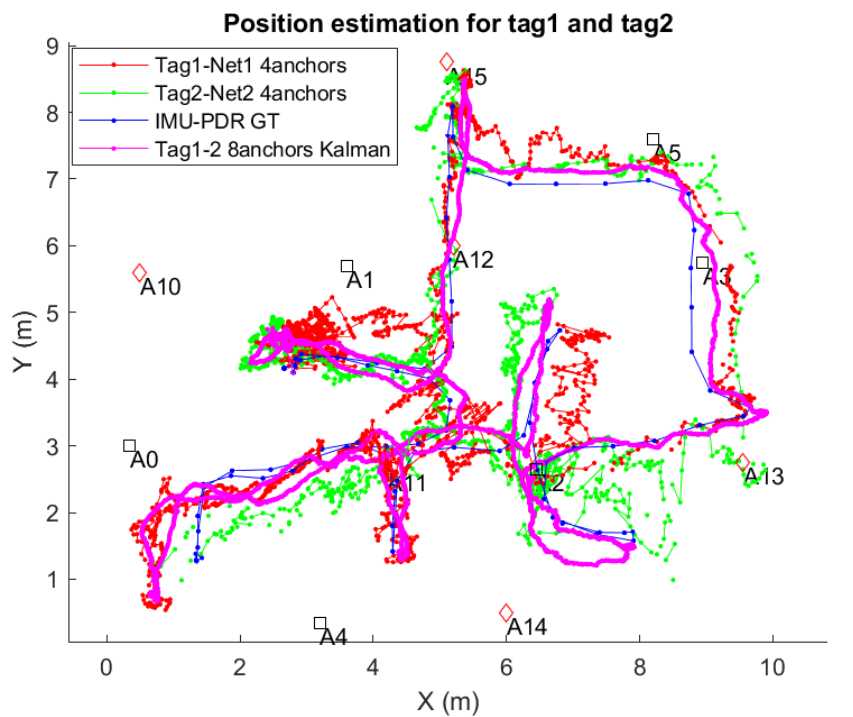
Figure 22. Localization results at the apartment